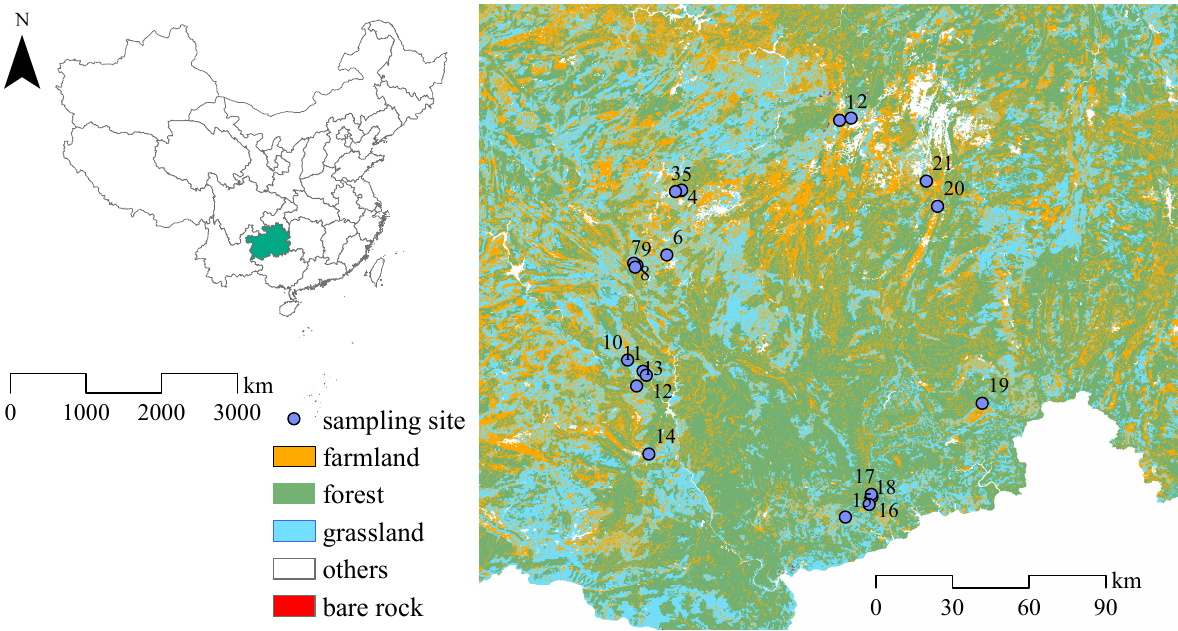
Figure 1. Study sites locations in Guizhou Province, China. Note: 1: Catalpa ovata ; 2: Cryptomeria japonica var. sinensis ; 4: Cupressus funebris ; 7: Toona sinensis ; 17: Liquidambar formosana ; 20 Pinus massoniana ; 1, 2, 4, 7, 17 and 20 are ecological forest. 5: Secondary forest; 13: Natural grassland; 19: Natural shrub tussock. 3, 6, 8, 16 and 21 are abandoned grassland; 9: Vitis vinifera ; 10: Prunus salicina var.; 11: Hylocereus undatus ; 12: Zanthoxylum bungeanum ; 14: Prunus salicina var.; 15: Artificial grassland; 18: Eucalyptus robusta . 9, 10, 11, 12, 14, 15 and 18 are economic plantation. Sites 3, 4, 5, 6, 10, 11, 12, 13, 14 and 19 were on shallow soil depth, the others were on deep soil